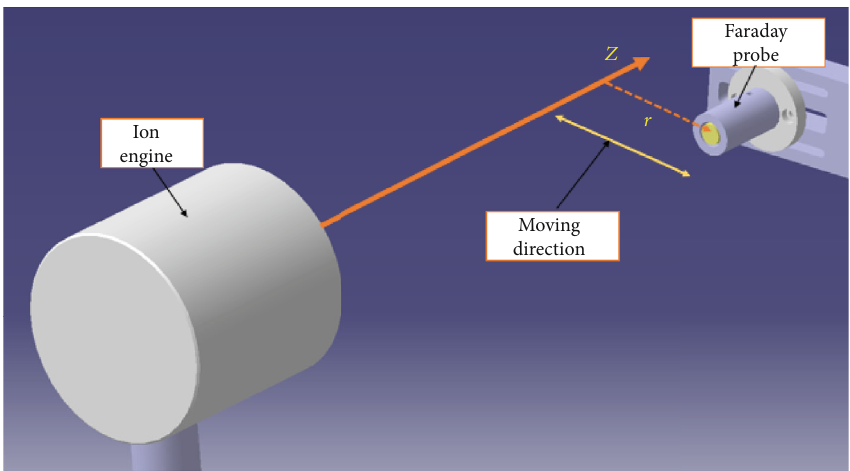
Figure 6: Schematic drawing of Faraday probe measurement system.